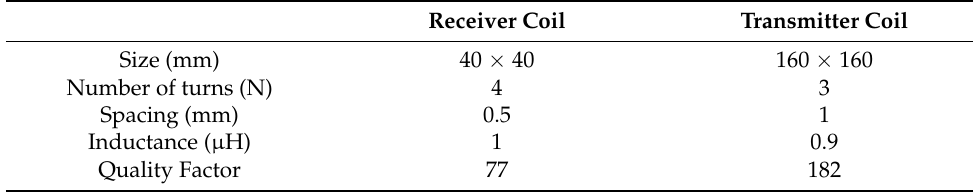
Figure 7. Schematic and Measurement setup of proposed WPT configuration. ( a ) Schematic block diagram of the measurement setup. ( b ) Measurement set up and test setup using array and the RX module and measurement equipment and ( c ) fabricated star shaped coils and RX module. Table 1. Specification of the fabricated coils. Table 1. Specification of the fabricated coils.